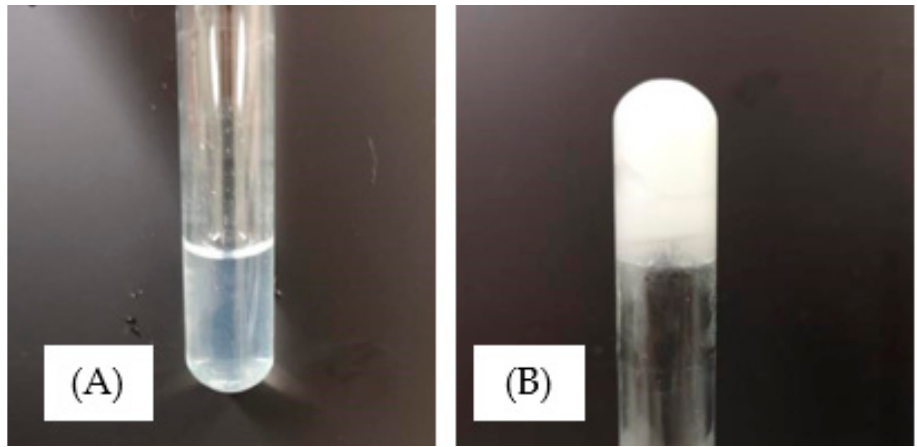
Figure 9. Illustration of the gelation temperature of the ungelled ( A ) and gelled samples ( B ).